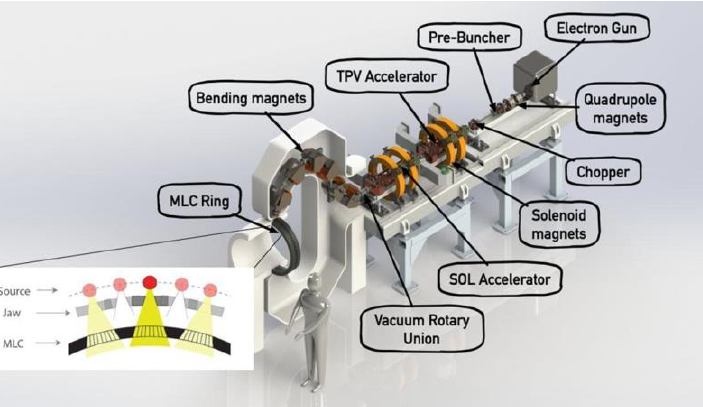
Figure 13. Rendering of the ROAD FLASH-RT system. A segment of the decoupled MLC ring is shown in the figure inset with three MLC modules. The linac is triggered to produce the beam when the target is aligned with the MLC to produce a VMAT-like treatment.